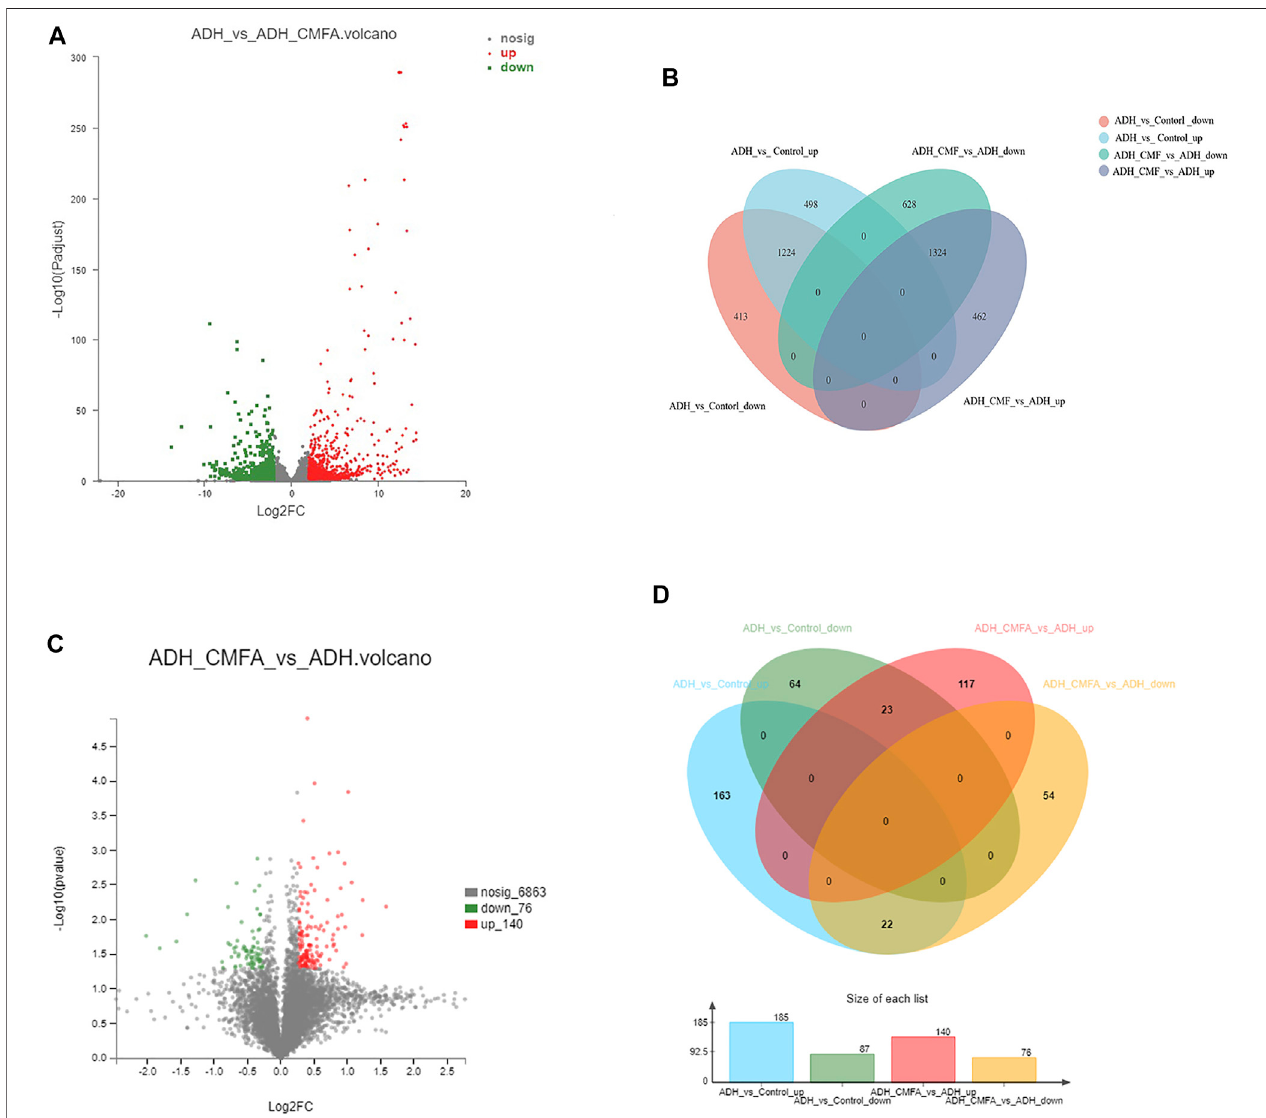
FIGURE 2 | Number of differentially expressed genes and proteins. (A) mRNA volcanogram of differential expression (B) mRNA venn diagram of differential expression (C) proteins volcanogram of differential expression (D) proteins venn diagram of differential expression.